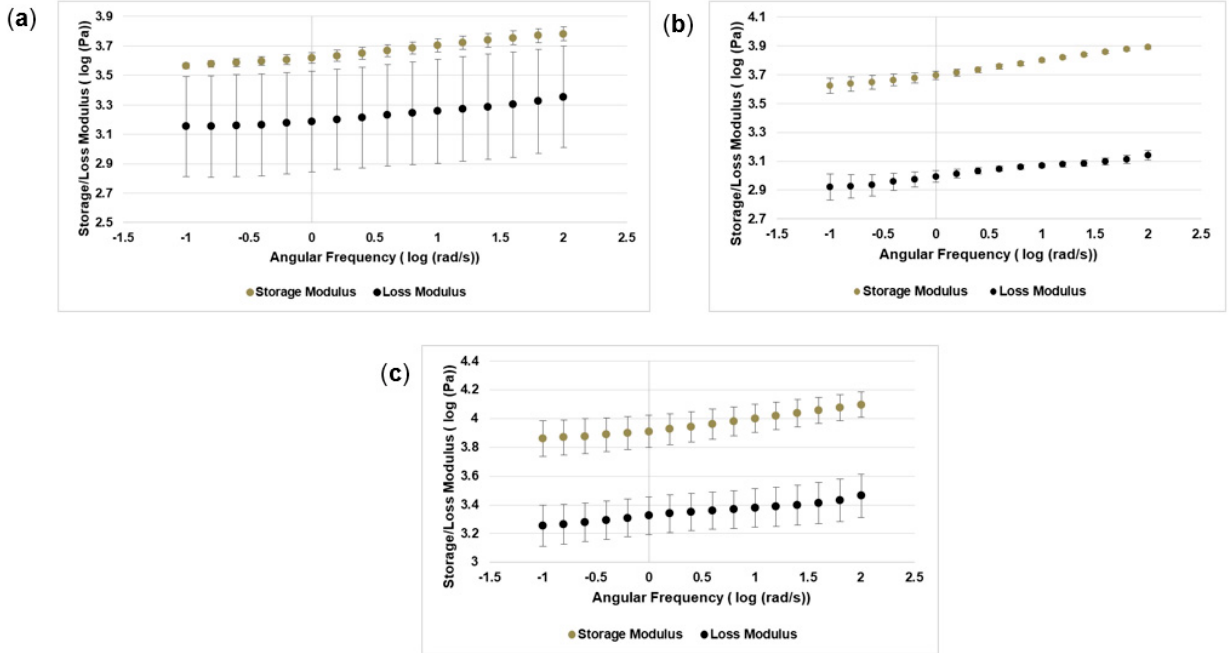
Figure 7. Rheological properties. ( a ) Storage/loss modulus of bioprinted constructs with 1 million cells and microspheres. ( b ) Storage/loss modulus of bioprinted constructs with 2.5 million cells and microspheres. ( c ) Storage/loss modulus of bioprinted constructs with 5 million cells and microspheres.